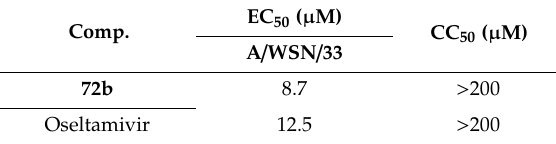
Table 28. The anti-influenza activity of the pentacyclic triterpene ASA conjugate 72b . Comp.